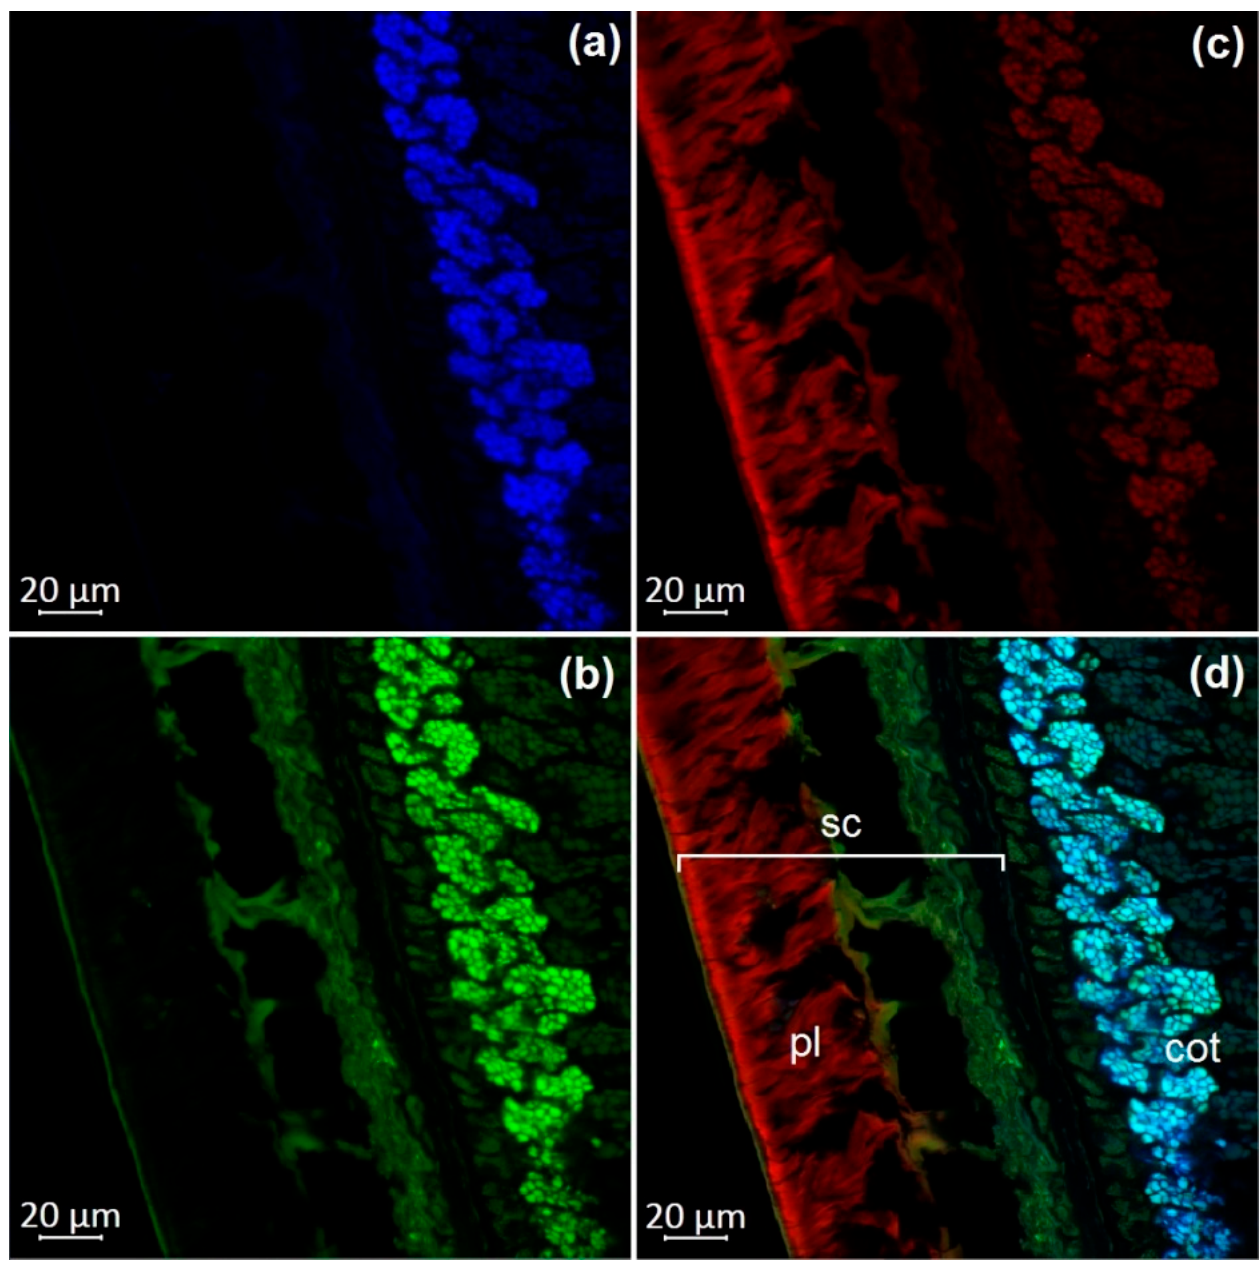
Figure 2. A transverse section of a soybean seed (variety k-11538): ( a ) excitation at 405 nm with emission in the range of 400–475 nm (blue); ( b ) excitation at 488 nm with emission in the range of 500–545 nm (green); ( c ) excitation at 488 nm with emission in the range of 620–700 nm (red); ( d ) merged; cot, cotyledon; pl, palisade layer; sc, seed coat. The blue-light-induced green autofluorescence in the range of 500–545 nm can be explained by the presence of flavins and flavonols (myricetin, quercetin, and kaempferol) and their derivatives [7,25,26]. The emission in the red spectrum mainly occurs due to the presence of anthocyanins and anthocyanidins